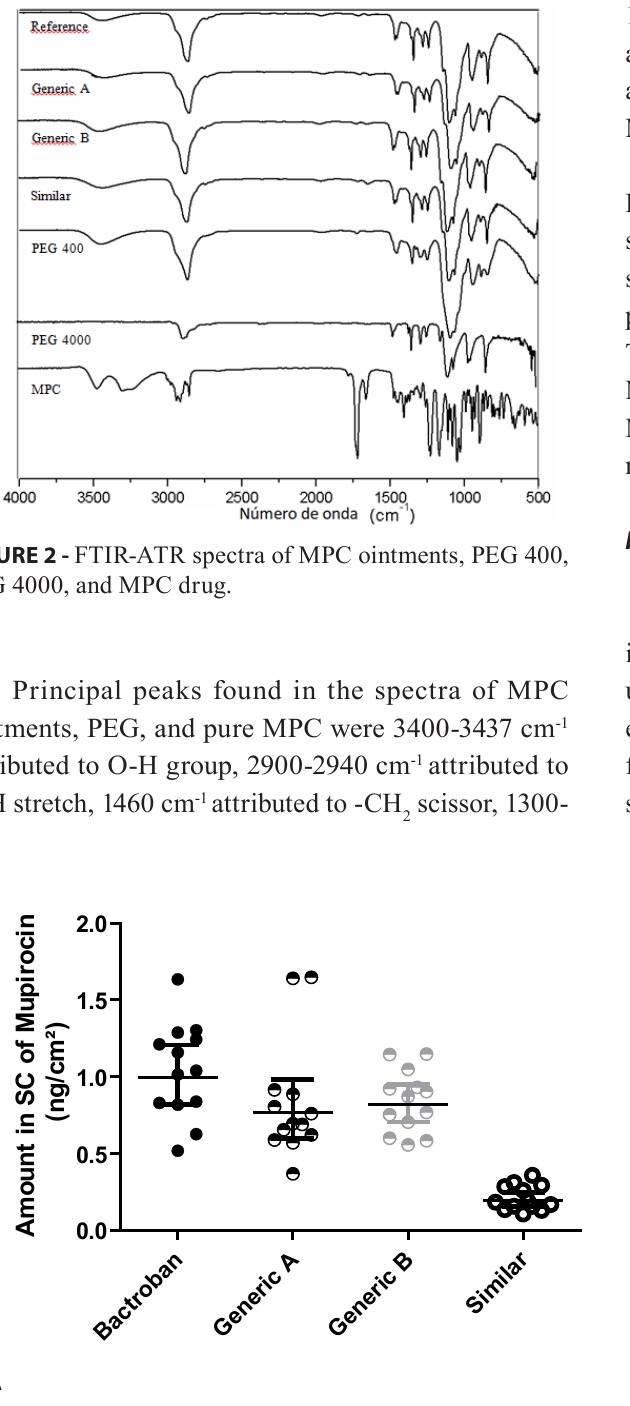
FIGURE 3 - Amount of MPC (ng/cm 2 ±SD) in the stratum corneum (panel A) and epidermis and dermis (panel B) in dorsal pig skin (n =14), for the 4